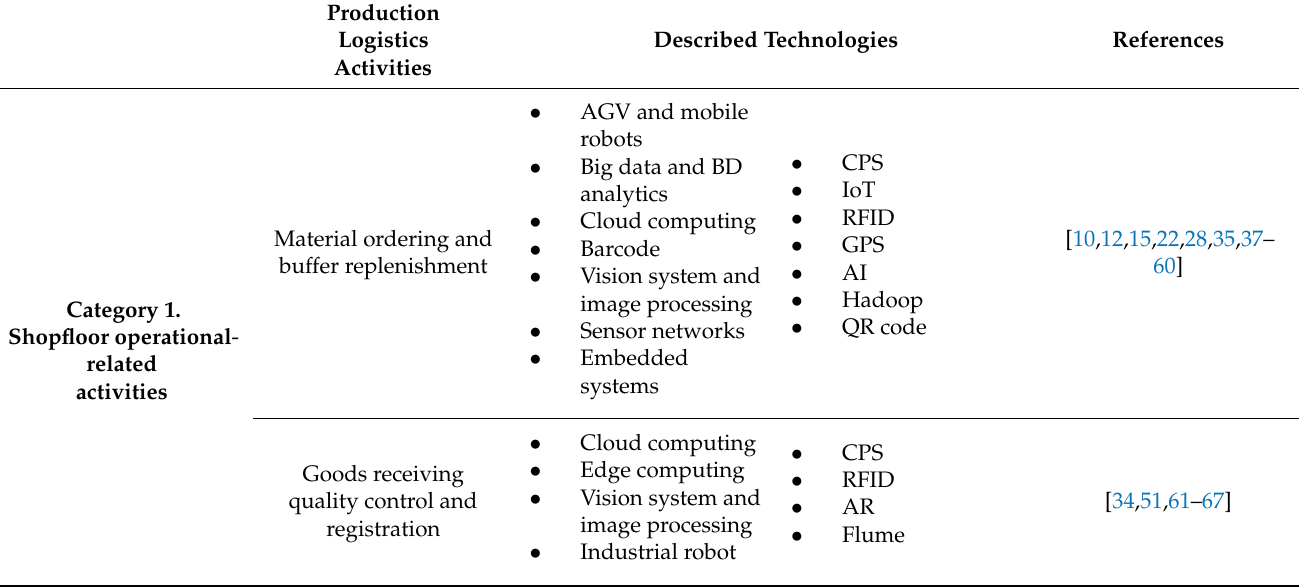
Table 3. Production logistics activities in Category 1 and association with the identified technologies in the